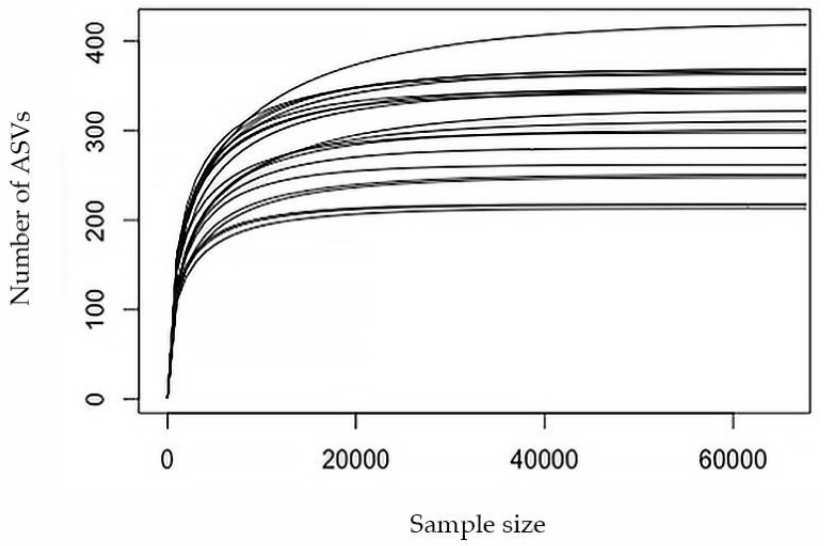
Figure 1. Rarefaction curves based on the number of reads (sample size) and the number of ASVs in each sample. Each line represents one sample. No significant differences were recorded. The Shannon index of bacterial communities measured on the number of ASVs de- tected did not show a difference in the diversity in the two different conditions ( p value = 0.91) (Figure